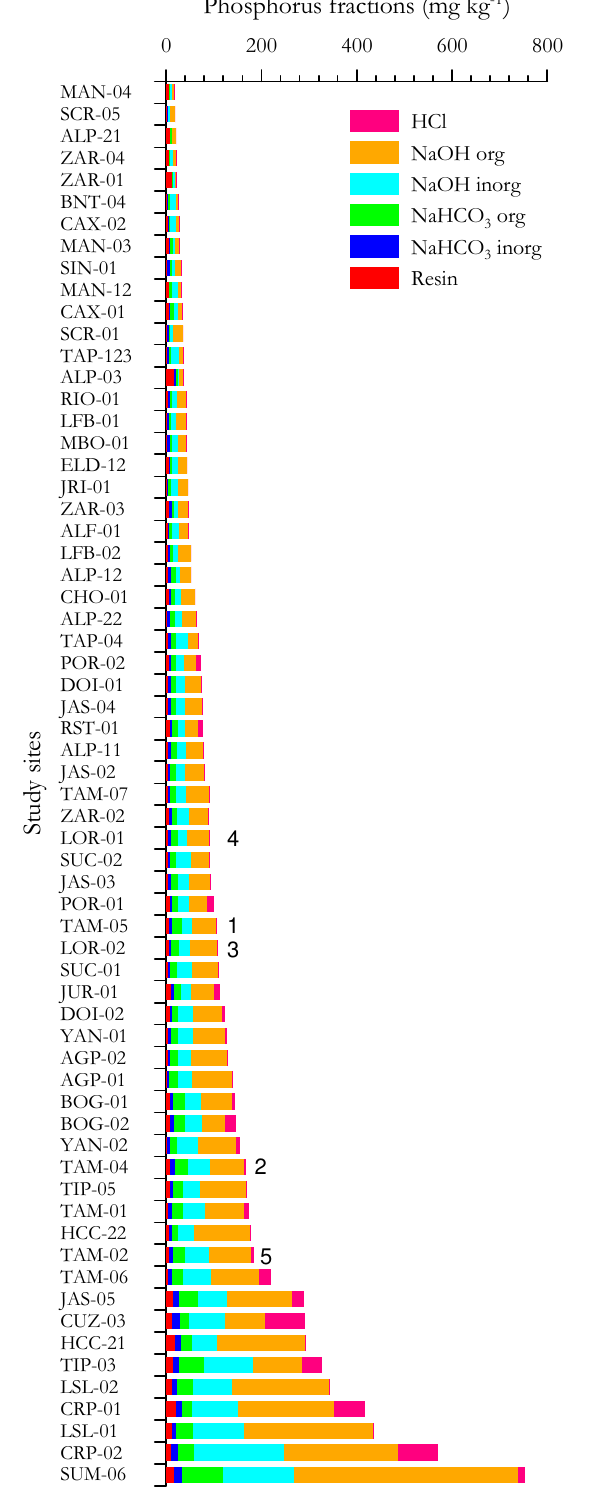
Fig. 6. Phosphorus concentrations per extractable fraction for each study site. Residual phosphorus was not included.